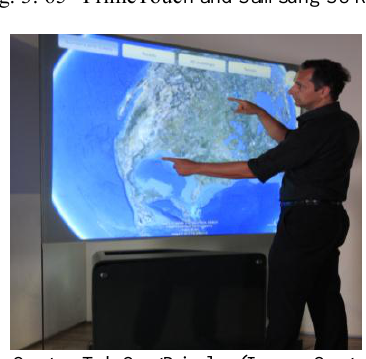
Fig. 4: GestureTek GestDisplay (Image: